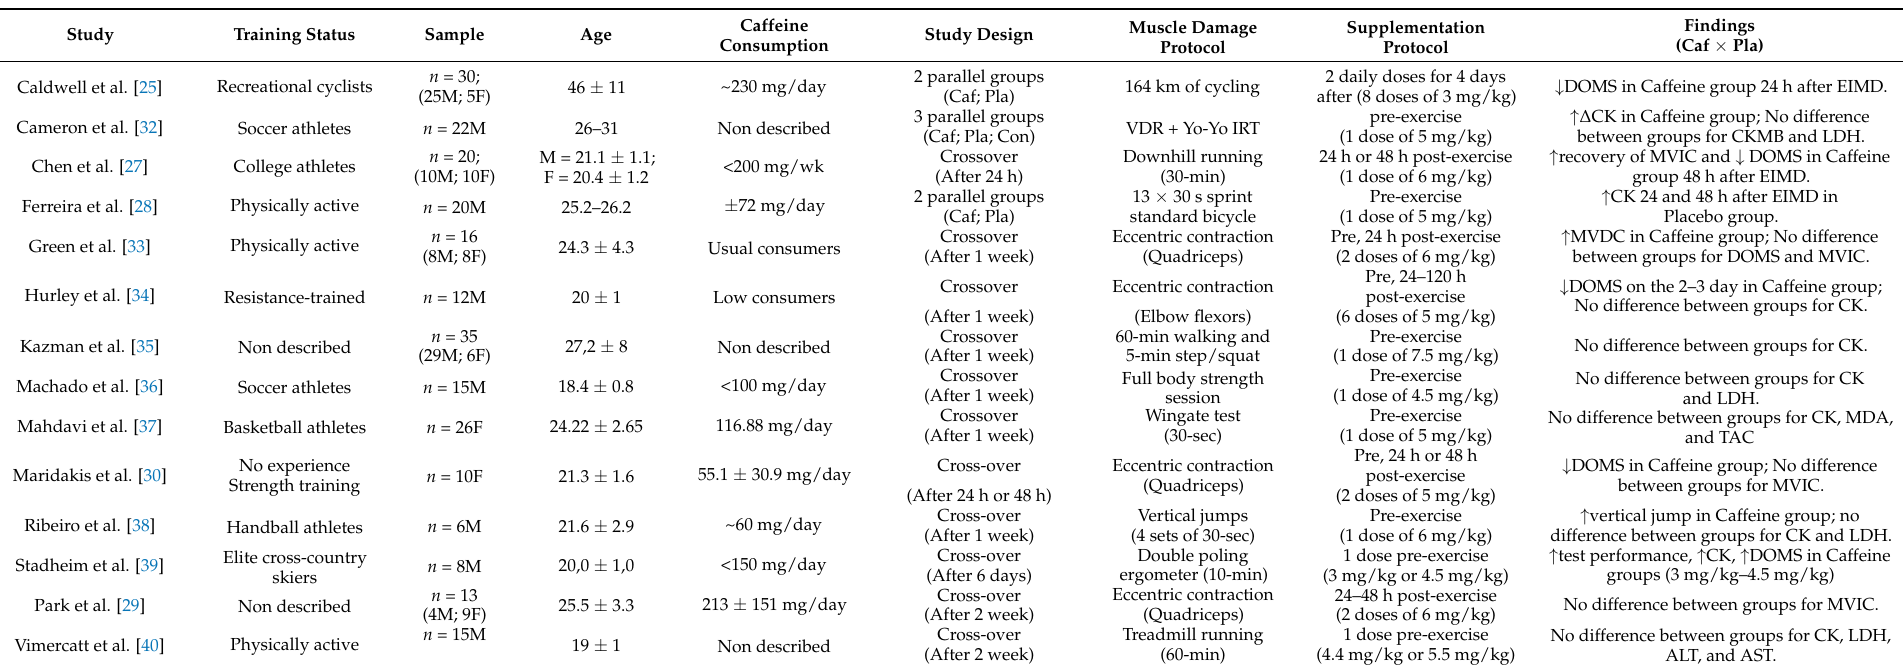
Table 1. Characteristics of the studies and main